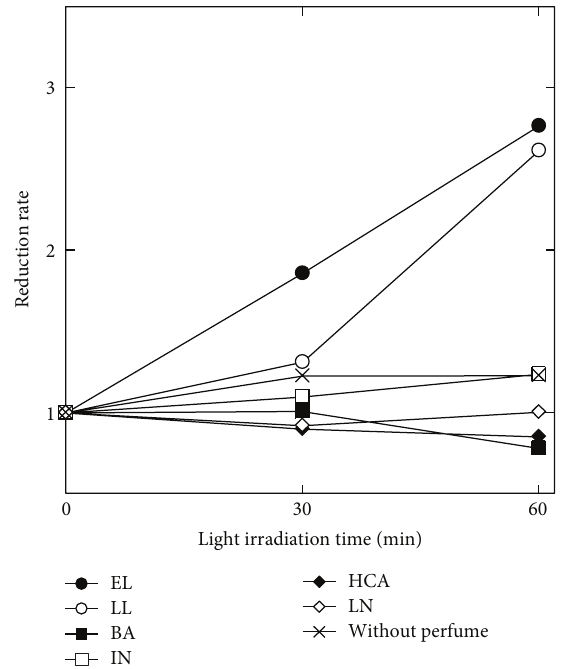
Figure 4: Concentration of synthetic perfumes in O/W emulsion after light irradiation.